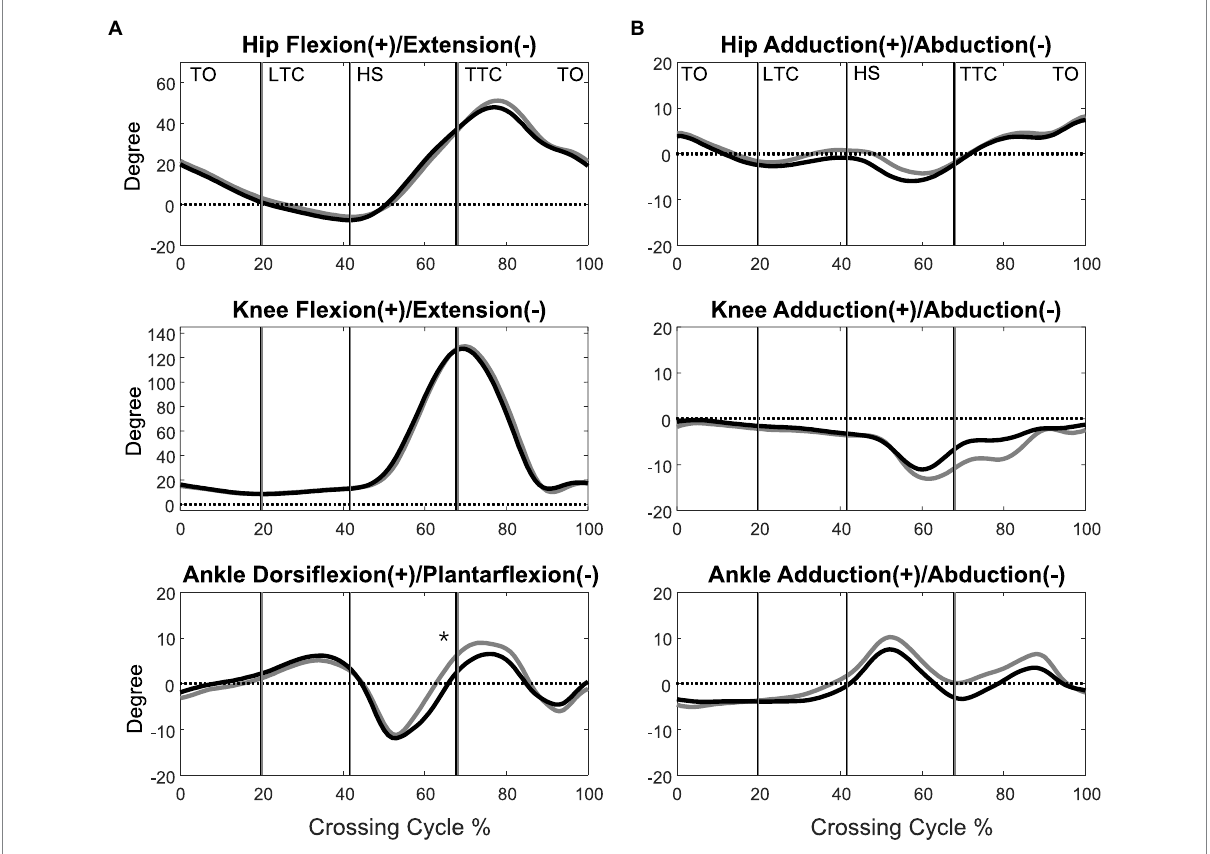
FIGURE 2 The mean curves of the angles of the hip, knee, and ankle joints of the trailing limb in the sagittal (A) and frontal plane (B) in the MCI (black) and control (grey) groups when crossing obstacles of 30% of leg length. (TO, toe-off of the leading limb; LTC, leading toe above the obstacle; HS, heel-strike of the leading limb; TTC, trailing toe above the obstacle; *significant main group effect, p < 0.05).